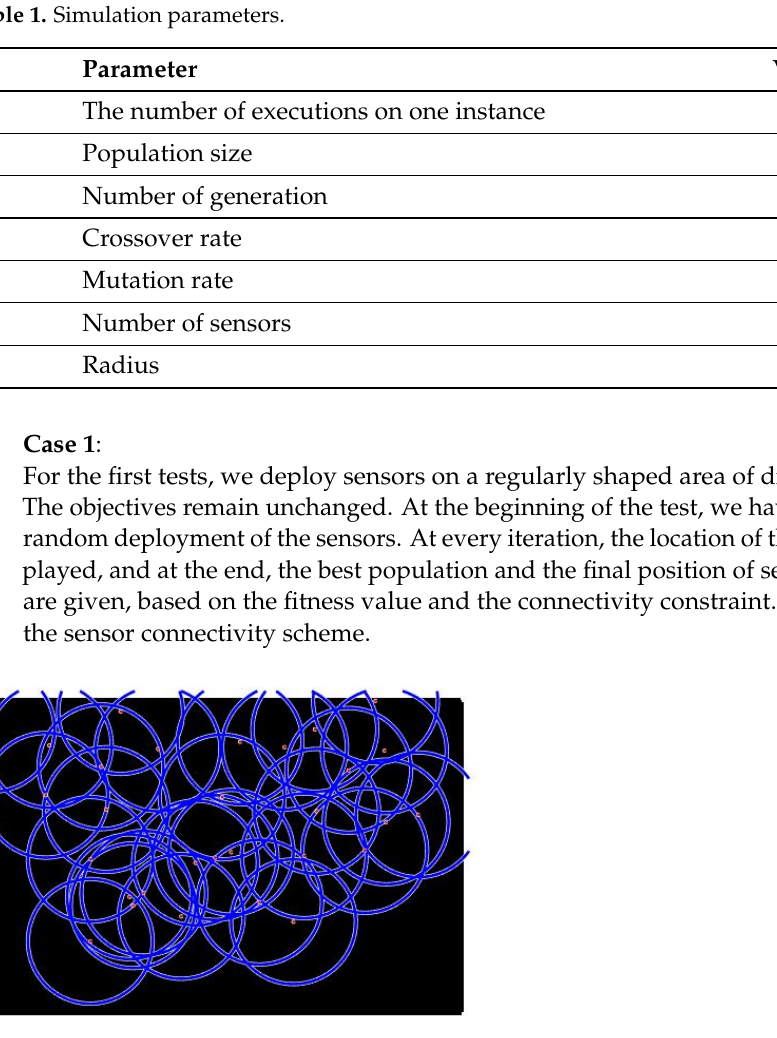
Figure 8. Final deployment.